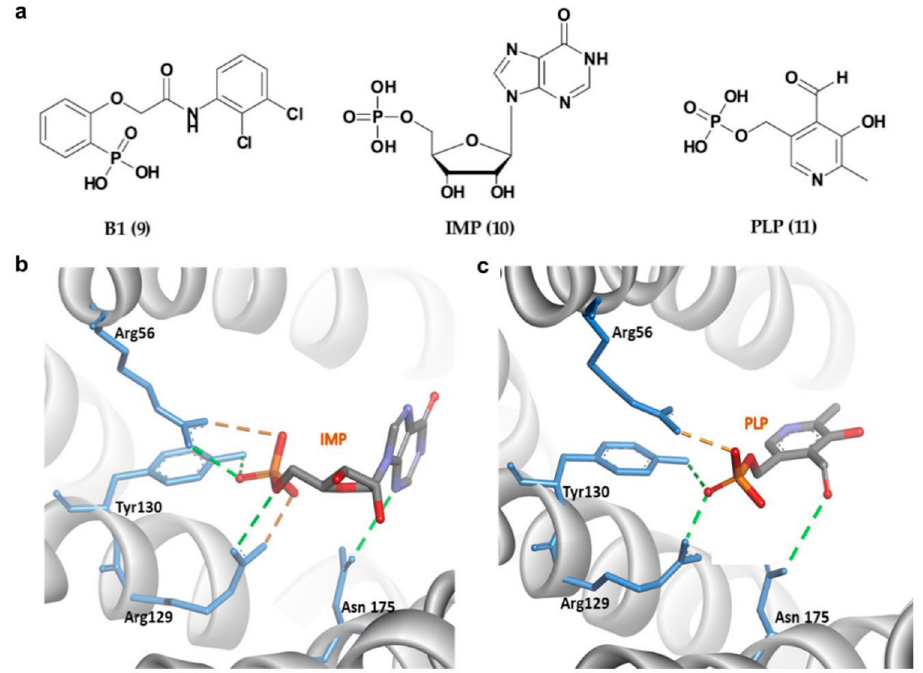
Figure 6. ( a ) Chemical structure of phosphonate- and phosphate-type small molecule inhibitors of 14-3-3 σ . ( b ) 14-3-3 σ / IMP complex (PDB 6TLF). ( c ) 14-3-3 σ / PLP complex (PDB 6TM7). Hydrogen bond and ionic interactions are shown as green and orange dashed lines, respectively.